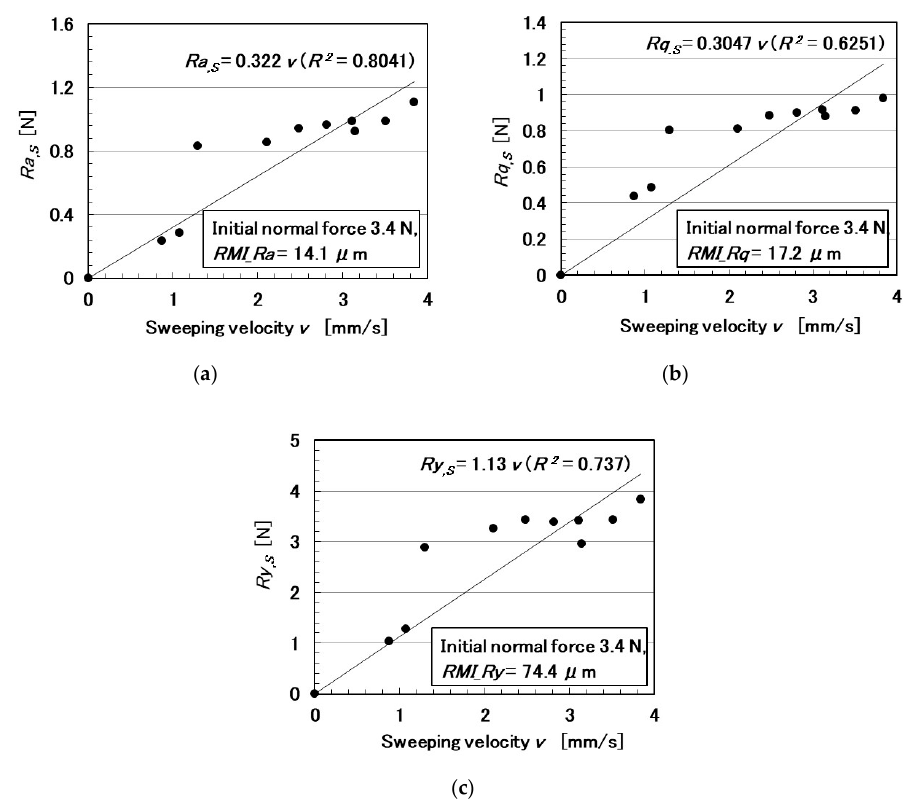
Figure 10. Relationship between shear force and sweeping velocity: ( a ) Ra .; ( b ) Rq .; and ( c ) Ry .